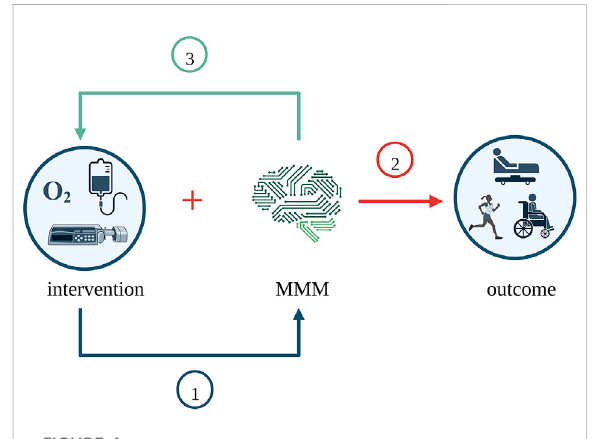
FIGURE 4 Purposesofinterventionsacross theMMMstudies. MMM was examined in three different ways across the studies. Firstly, MMM wastheoutcome,andtheintervention ’ seffectivenesswasstudied. Secondly, MMM was considered along with the intervention for its effect on clinical outcome.Thirdly, thresholds of MMM were used to dictate intervention, and the need for intervention was studied. Created with BioRender.com. MMM, multimodality monitoring.